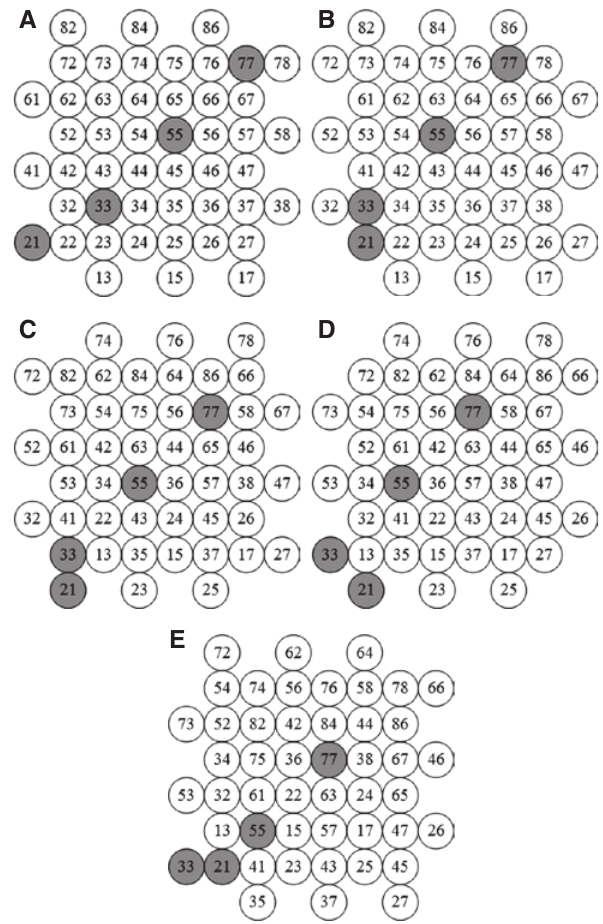
Figure 2: Four-step